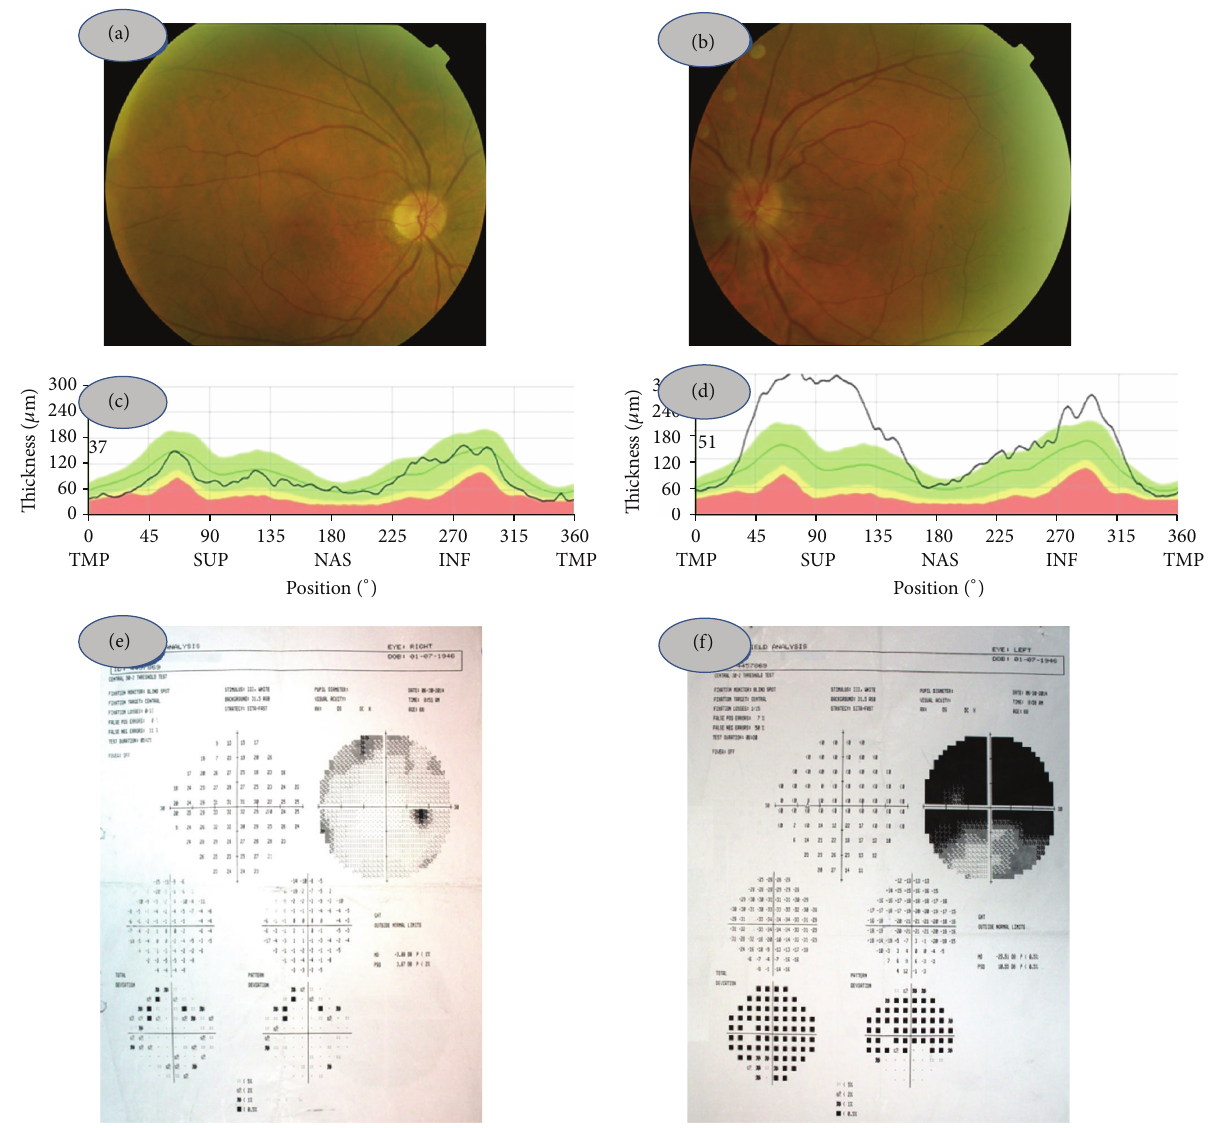
Figure 1: Colour fundus picture of the right eye (a) and left eye (b), retinal nerve fiber layer thickness in OD (c) and OS (d), and visual fields in OD (e) and OS (f) at the initial examination prior to left intravitreal aflibercept